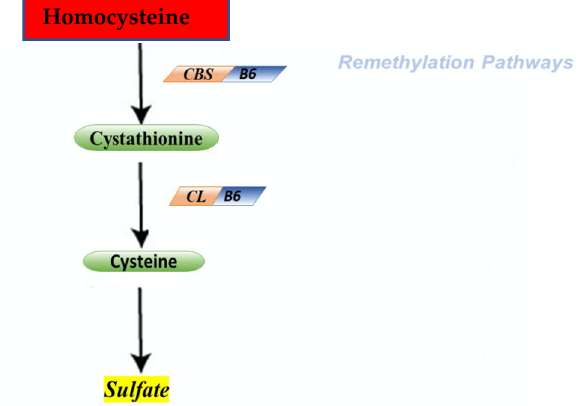
Figure 3. Remethylation pathways. Second step is represented by remethylation of homocysteine. CBS—cystathionine – β – synthase; CL—cystathionine – γ – lygase.